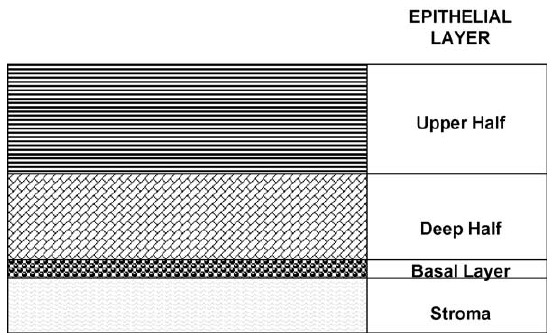
Fig. 1. Diagram illustrating the different layers in which the mea- surements were